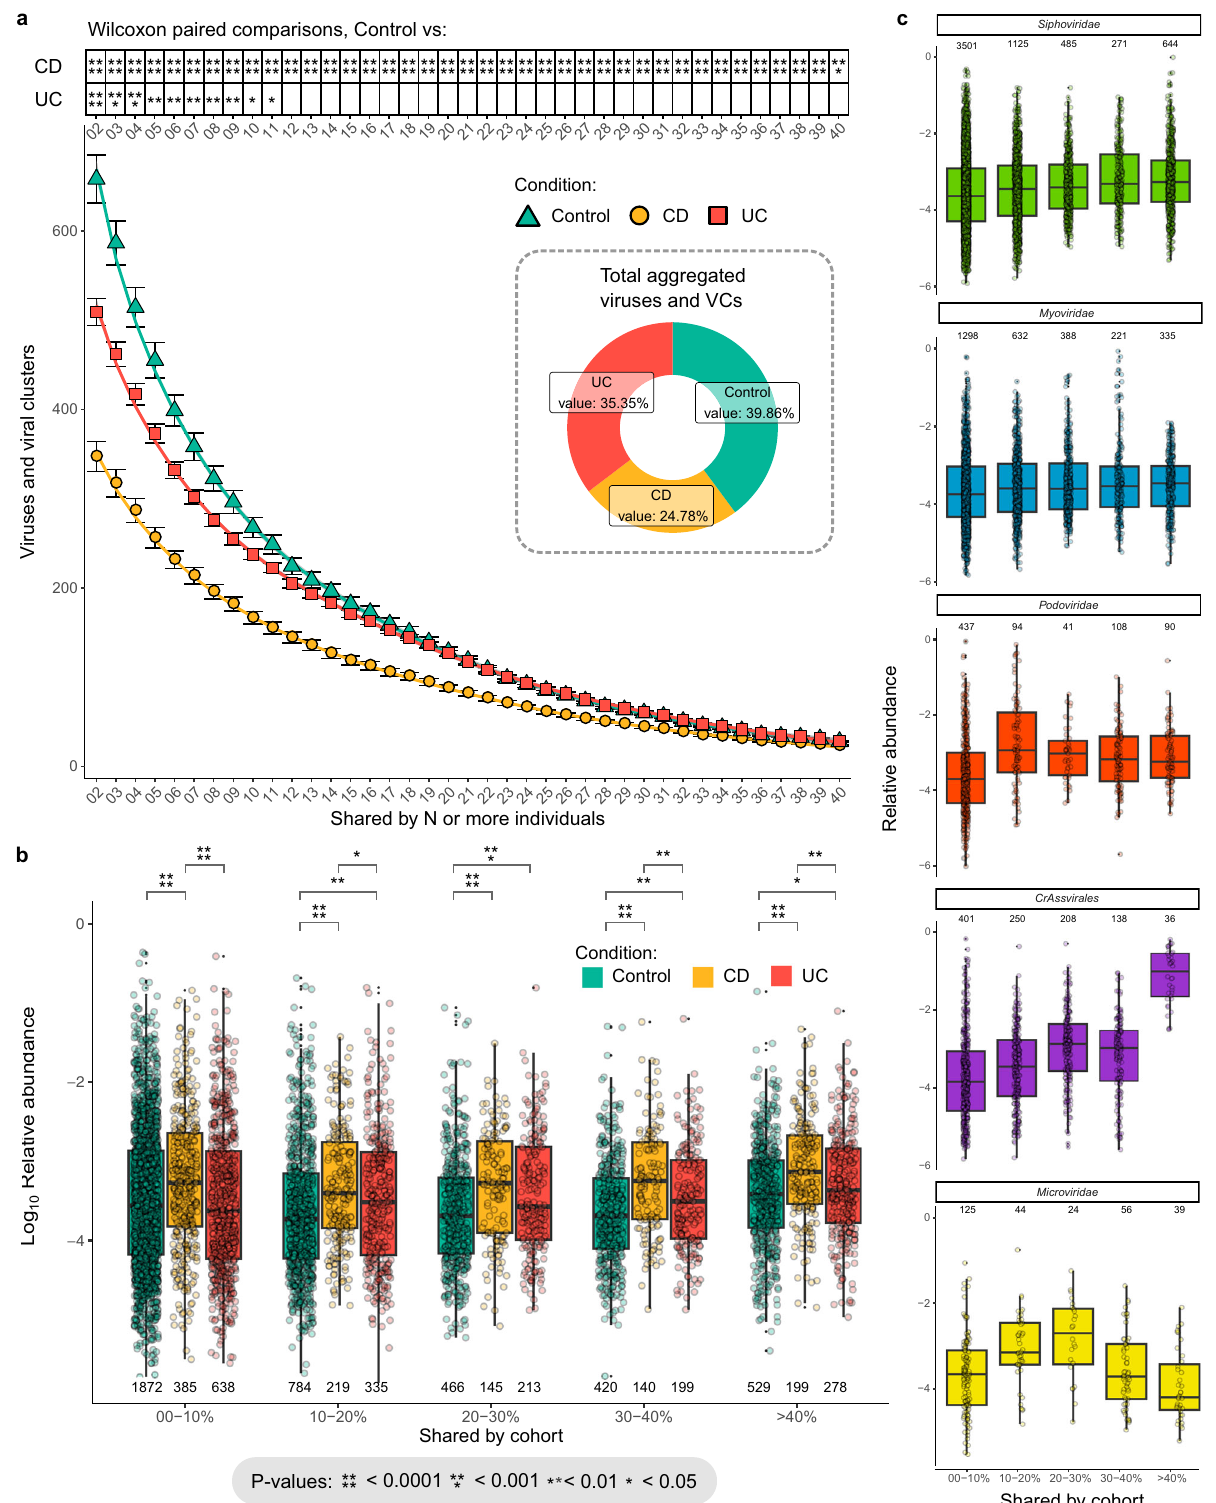
Fig. 3 Communal and compositional analyses of unampli fi ed faecal viromes. a The number of communal viruses and viral clusters (VCs) shared by an increasing number of control, CD, and UC individuals. Bootstrapped subsampling of a single time point from 10 random individuals, for each condition, was performed 20 times. The relative abundance of faecal viruses, demonstrating b lysogenic phages shared between increasing percentages of control, CD, and UC individuals (Student ’ s t test was used to calculate statistical differences between cohorts), and c the prevalence of dominant viral taxa shared amongst increasing percentages of the total cohort individuals. The values at the top of each boxplot indicates the number of viruses or VCs averaged. Boxplots represent the standard Tukey representation, with boxes representing the 25th, 50th (median) and 75th interquartile range (IQR) percentiles, and the whiskers encompassing values within 1.5 times the